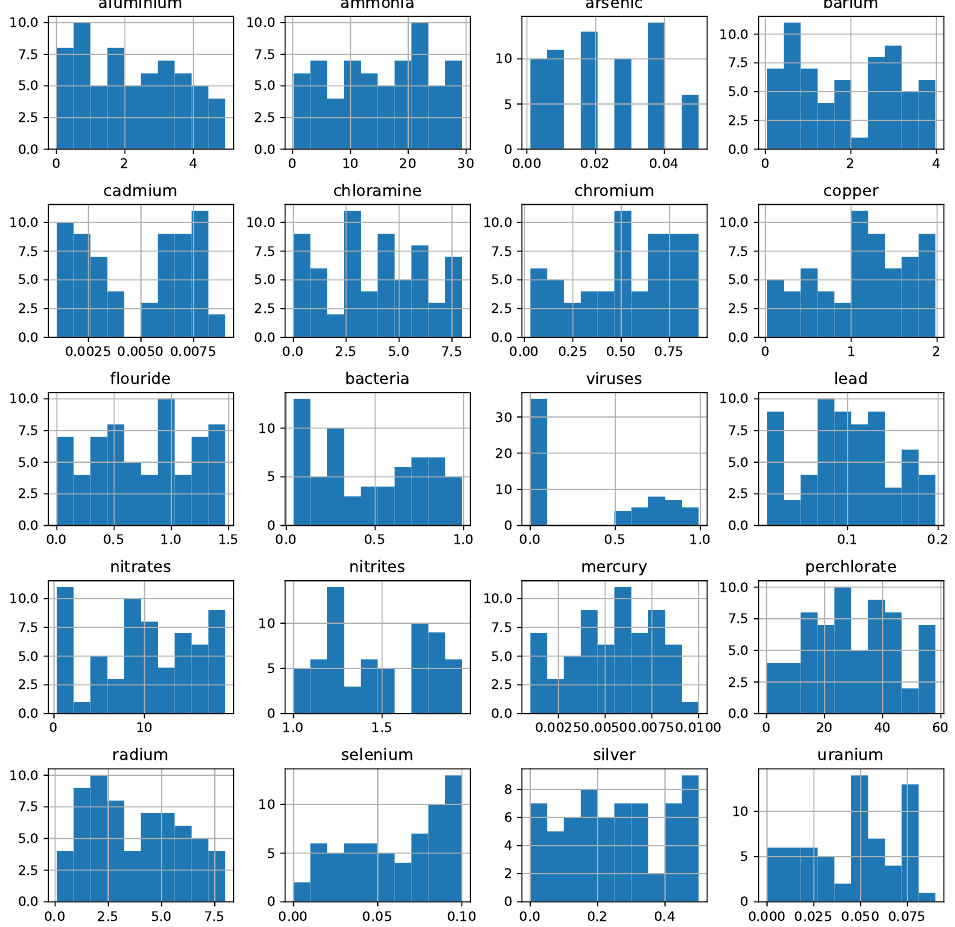
Figure 2. Distribution of water-containing compounds from the